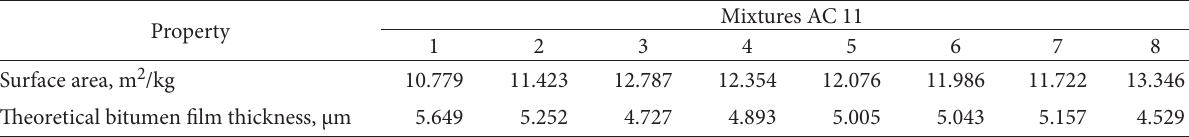
Table 3. Aggregate surface area and calculated bitumen film thickness of tested mixtures Property